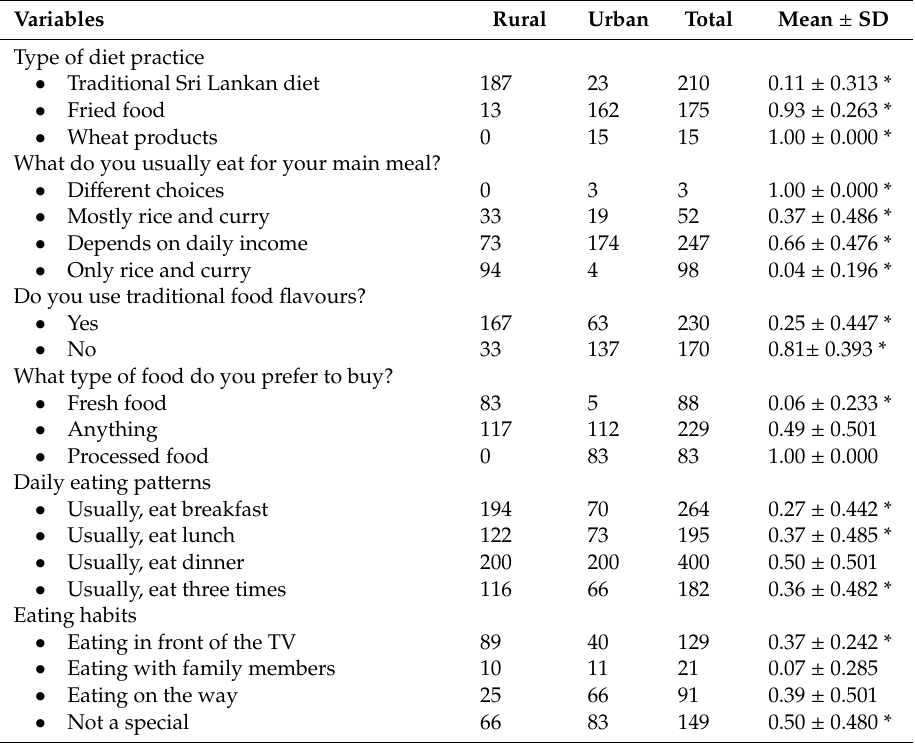
Table 6. Reproductive-age women’s food practices in rural and urban areas of Sri Lanka ( N = 400). Variables Rural Urban Total Mean ±